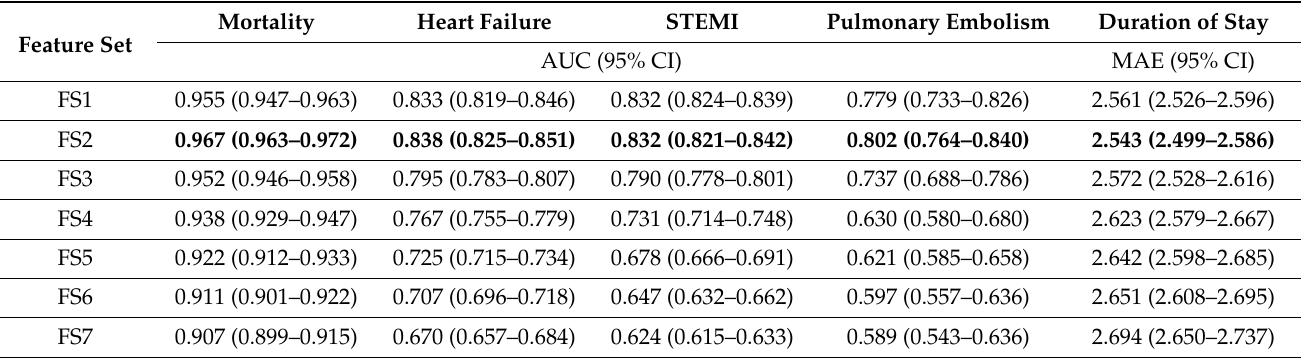
Table 2. Performance of the proposed method in terms of area under receiver operating characteristic curve (AUC) for predicting mortality, heart failure, ST-segment elevation myocardial infarction (STEMI), and pulmonary embolism and in terms of mean absolute error (MAE) for estimating the duration of stay for various set of input features. FS1 constitutes all the features. Features with cumulative importance of less than 1% are excluded from FS1 to form FS2. The most significant feature from FS2 is removed to form FS3. Similarly, FS4, FS5, and FS6 are formed by excluding the most significant feature from the corresponding super sets FS3, FS4, FS5, and FS6, respectively. Optimal performance (highlighted in bold) is obtained on feature set-2 (FS2) by excluding redundant